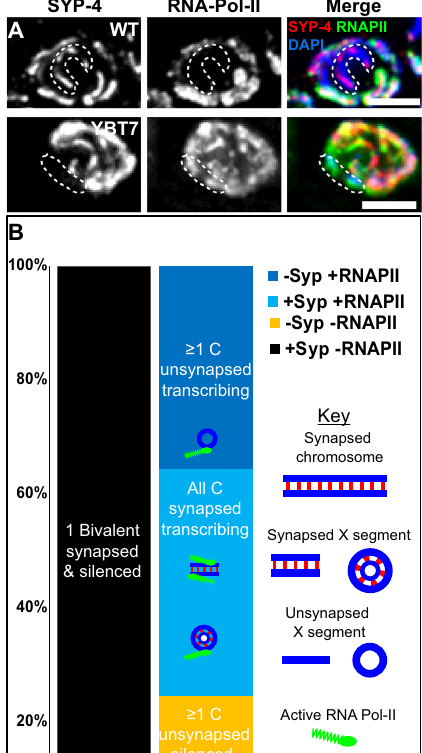
Fig. 7 Unsynapsed X segments are transcriptionally active. A Mid- pachytene nuclei of wild-type and YBT7 genotypes stained with DAPI (blue), anti-RNAPII (green), and anti-SYP-4 (red). Scale bar = 3 μ M. n = 42 and 73 nuclei for WT and YBT7, respectively. B Distribution of the percentages of wild-type and YBT7 early and mid-pachytene nuclei with a chromosome stained for SYP-4 but not RNAPII (black), one or more chromosomes lacking SYP-4 and RNAPII staining (yellow), all chromosomes stained with SYP-4 and RNAPII (light blue), and one or more chromosome stained without SYP-4 and with RNAPII (blue). Possible interpretations for the different categories are illustrated on the bars: In wild type, the synapsed chromosome that does not stain with RNAPII is probably chromosome X, and in YBT7 these are the synapsed X segments (black). In YBT7, the chromosomes without SYP-4 and RNAPII are segments of the X that are not synapsed and are silent (yellow). Nuclei that only contain chromosomes with SYP-4 and RNAPII have either lost the internal segment or both segments are synapsed and active (light blue). The chromosomes that stain with RNAPII but not with SYP-4 are the internal segments that cannot synapse and that escape both sex chromosome silencing and MSUC (blue). C Mid-pachytene nuclei stained with DAPI (blue), anti-RNAPII (green), anti-SYP-1 (red), and anti-HIM-8 (white). n = 30 nuclei. D Mid-pachytene nuclei stained with DAPI (blue), anti-RNAPII (green), anti-SYP-4 (red), and left linc-20 (white). n = 27 and 40 nuclei for WT and YBT7, respectively. E Mid-pachytene nuclei stained with DAPI (blue), anti-RNAPII (green), anti-SYP-4 (red), and X left FISH probe (white). Dashed lines: HIM-8 or FISH marked body n = 21 and 47 nuclei for him-8 and YBT97, respectively. Scale bar = 3 μ